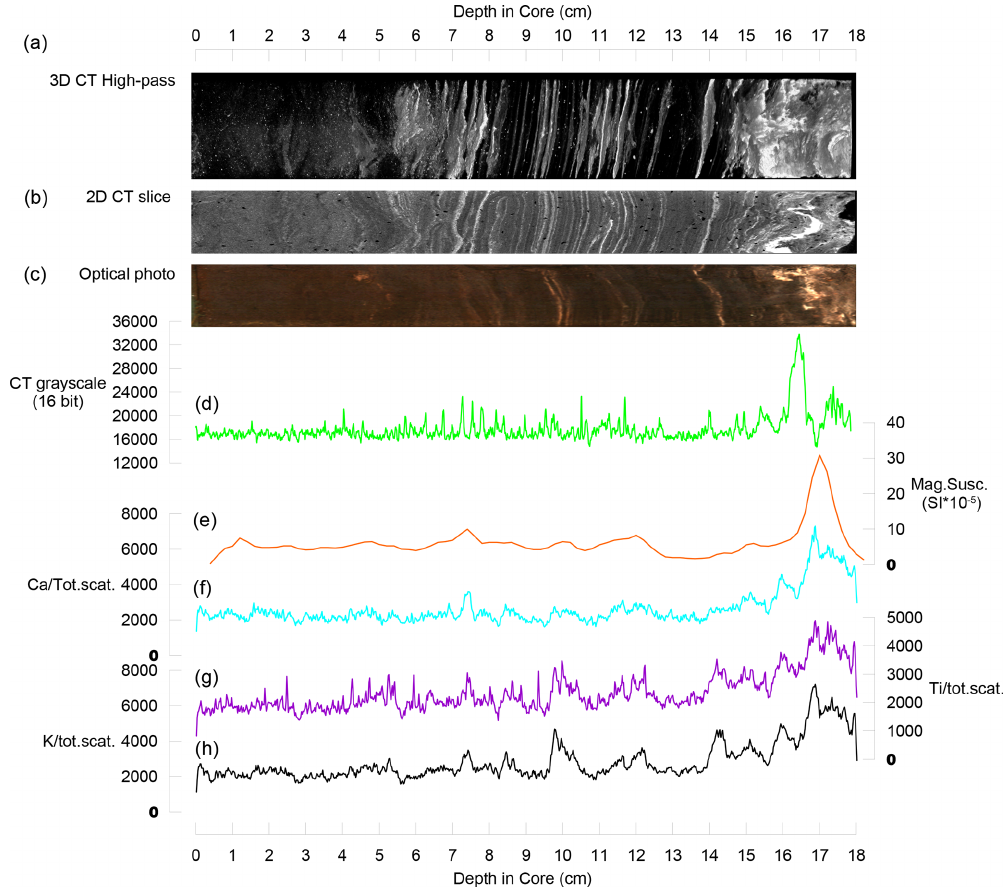
Figure 10. Results from high-resolution analysis of core FLS113. (a) shows a 3D CT visualization of high-density layers (white) in the core. (b) The 2D slice is an 80µm thick slice from the middle of the sediment core. (c) The optical photo is an RGB photo of the surface of the halved sediment core. The CT greyscale plot (d) shows an 80µm greyscale variability along a line through the middle of the sediment core. MS (e) is plotted as SI × 10 − 5 as magnetic susceptibility is a dimensionless parameter. (f–h) XRF data (K, Ca, and Ti) are normalized against total scatter to reduce the effect of water